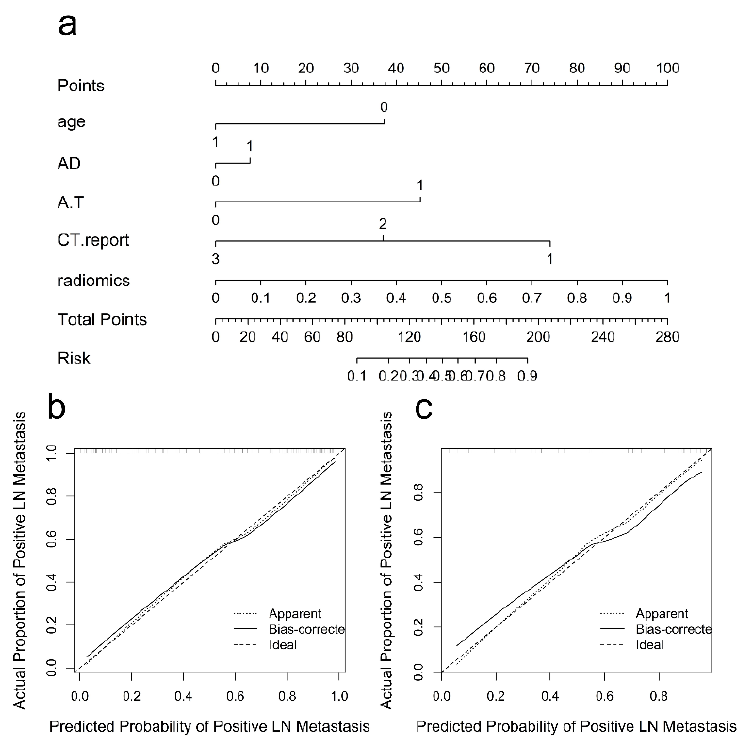
Figure 4. Comparison and calibration curves of the nomograms of the combined model. ( a ) A radiomics nomogram of the combined model incorporating age, AD, A/T, CT-reported lymph node status and radiomics signature. ( b ) Calibration curve of the nomogram of the combined model in the training cohort. The Hosmer–Lemeshow test yielded a nonsignificant statistic ( p = 0.454). ( c ) Calibration curve of the nomogram of the combined model in the test cohort ( p = 0.248). Calibration curves describe the model’s calibration in terms of agreement between the predicted probability of LNM and the actual lymph node status. The dotted line represents perfect performance, the gray solid line represents the actual performance and the black solid line represents the corrected prediction performance of the nomogram of the combined model. Abbreviations: LNM, lymph node metastasis; AD, anteroposterior diameter; A/T, anteroposterior to transverse diameter ratio; CT, computed tomography.